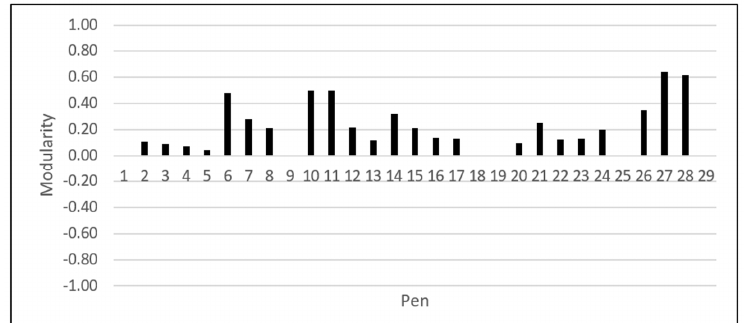
Figure 1. Modularity values estimated for each of the studied 29 Duroc pens.